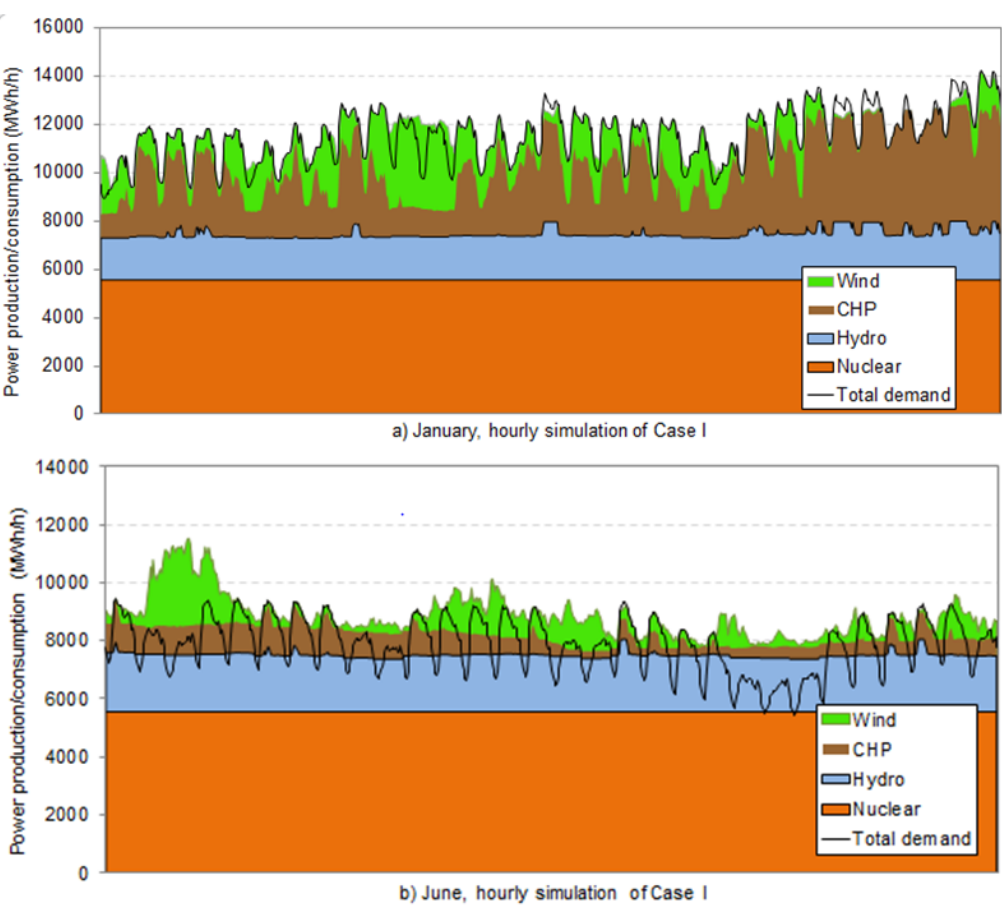
Figure 12. Variations in electricity demand and domestic power supply (excluding condensing plants) in ( a ) January and ( b ) June (Case I, without power imports, Table